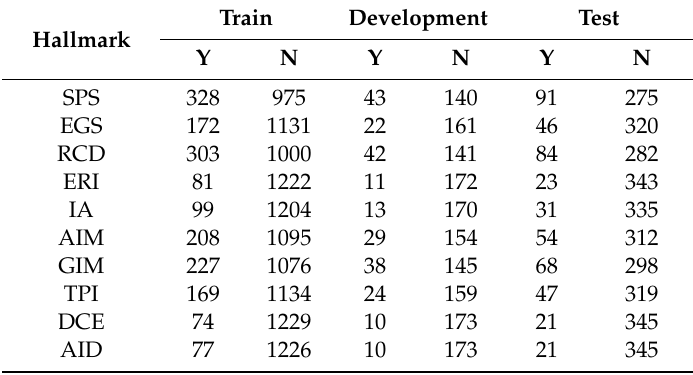
Table 3. Labeled datasets. Y: hallmarks and N: